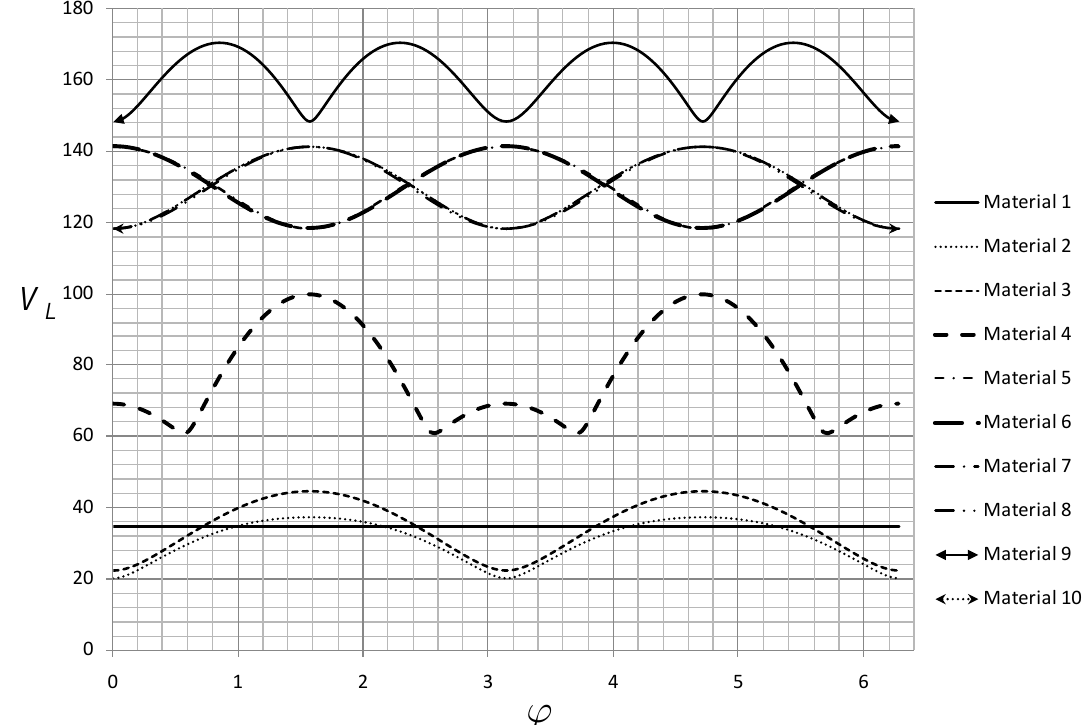
Fig. 3. Comparison of quasi-longitudinal wave velocity as a function of incidence